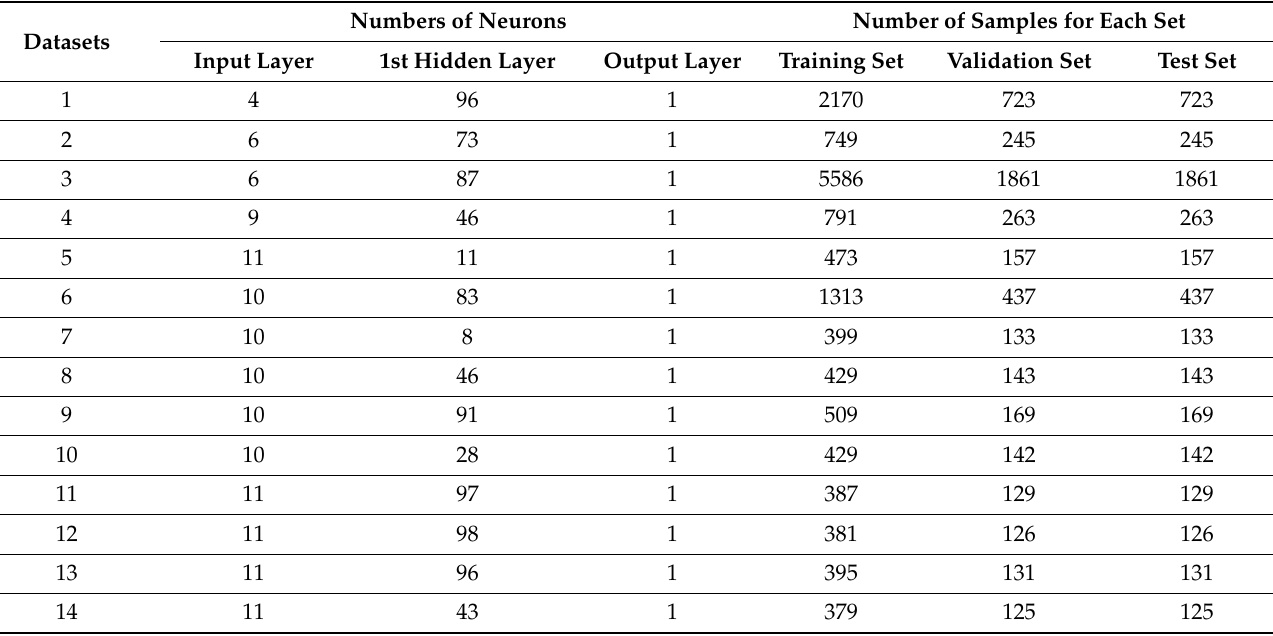
Table 7. Optimized parameters for the final model of the single hidden layer MLP